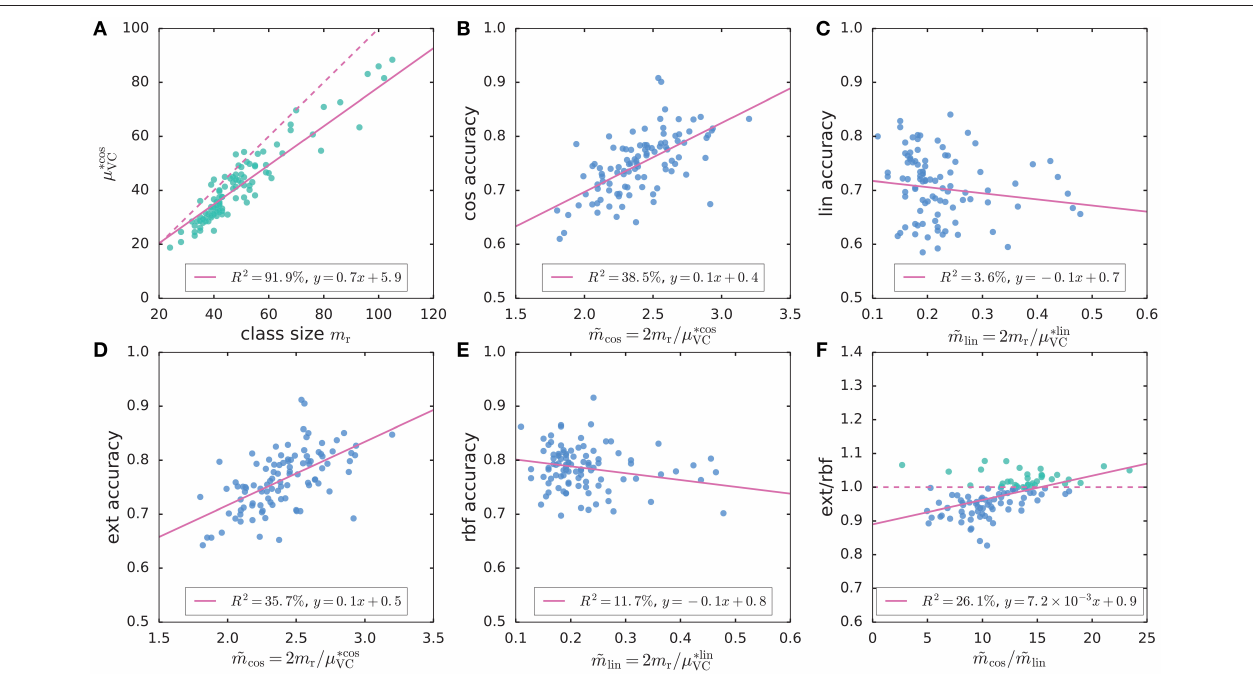
x ; the VC-bound for = m cos / m lin of ˜ ˜